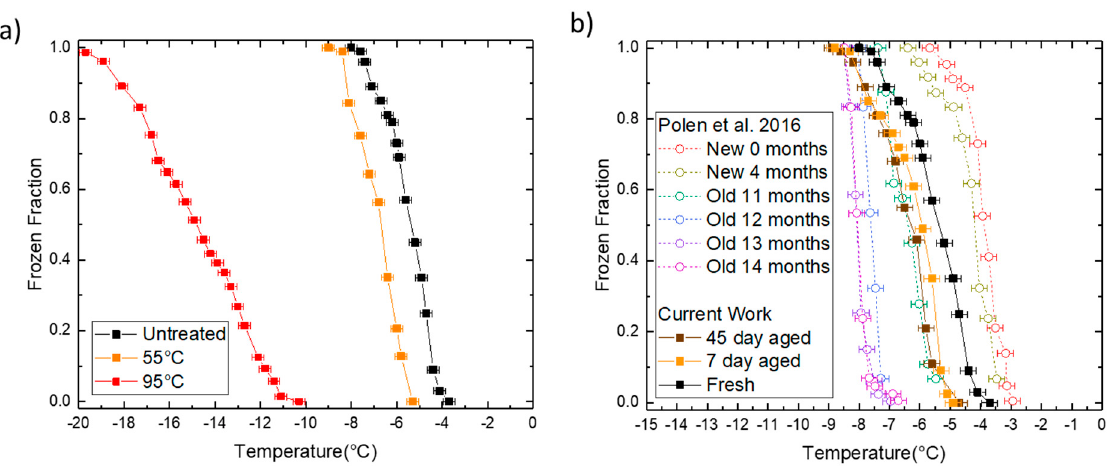
Figure 10. ( a ) A plot of the frozen fraction of heat treated Snomax ® samples as a function of freezing temperature; ( b ) A plot of the frozen fraction of room temperature aged Snomax ® samples as a function of freezing temperature.